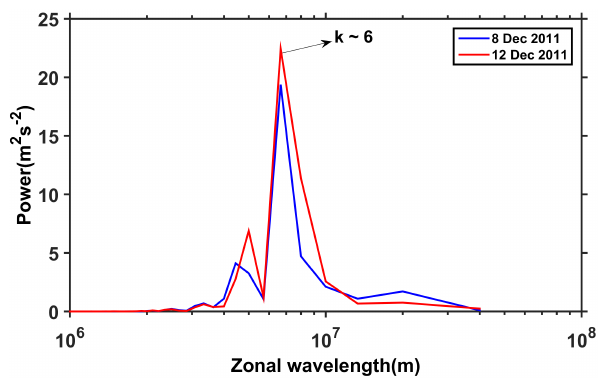
Figure 6. Power spectra of v 200hPa anomalies on 8 and 12 De- cember 2011. The spectra are obtained from the Fourier analysis of the longitudinal distribution of v 200hPa anomalies over the globe averaged for latitudes between 28–50 ◦ N. Both spectra show strong power near the zonal wave number